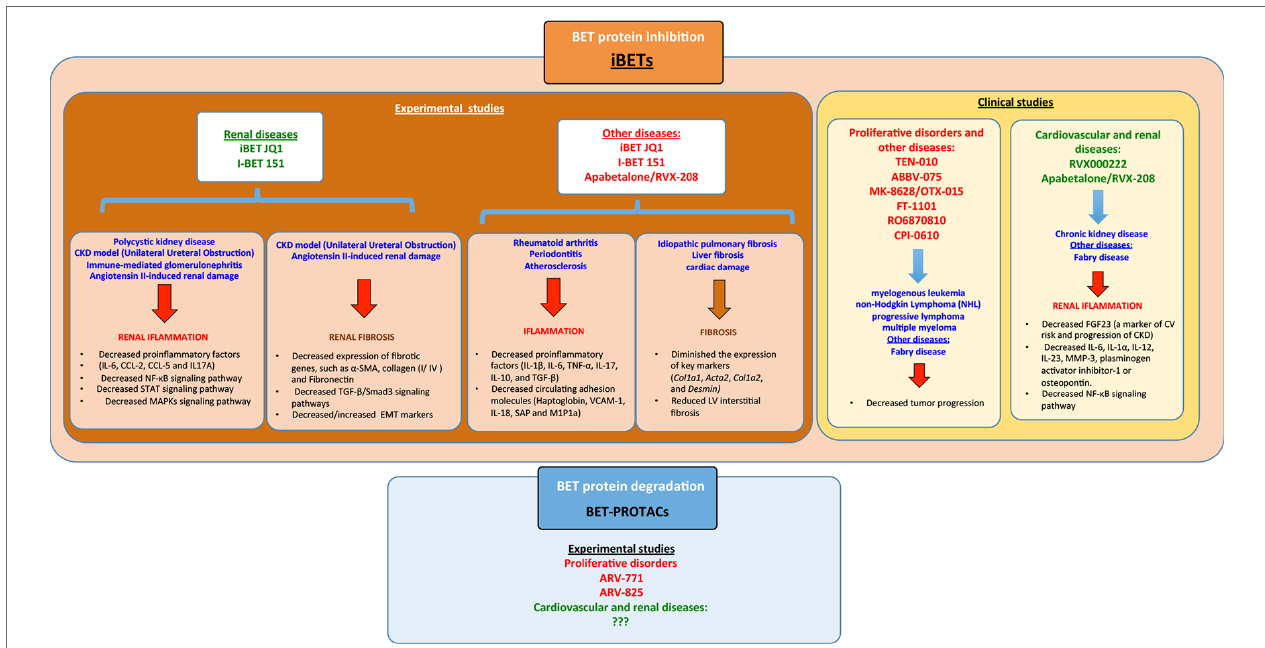
FIGURE 5 | Summary of the different bromodomain and extraterminal (BET) modulators in experimental/clinical studies in the context of several diseases including renal disease and the signaling pathways associated. iBETs interact with several signaling pathways to regulate inflammation and fibrosis.